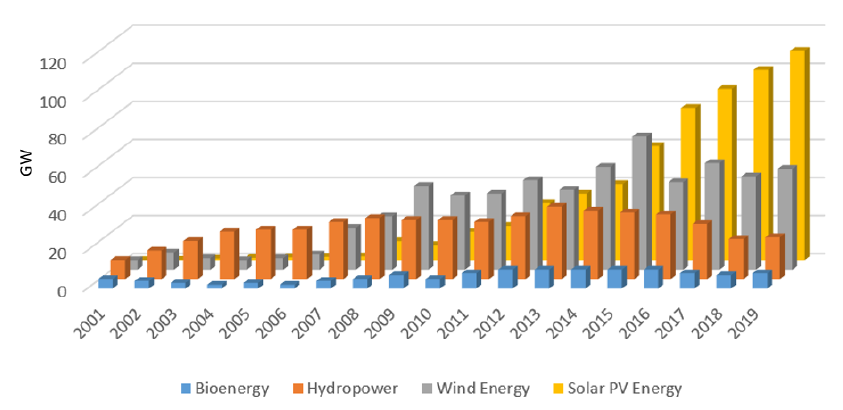
Figure 3. Global statistics of renewable energy systems for the period from 2001 to 2019.